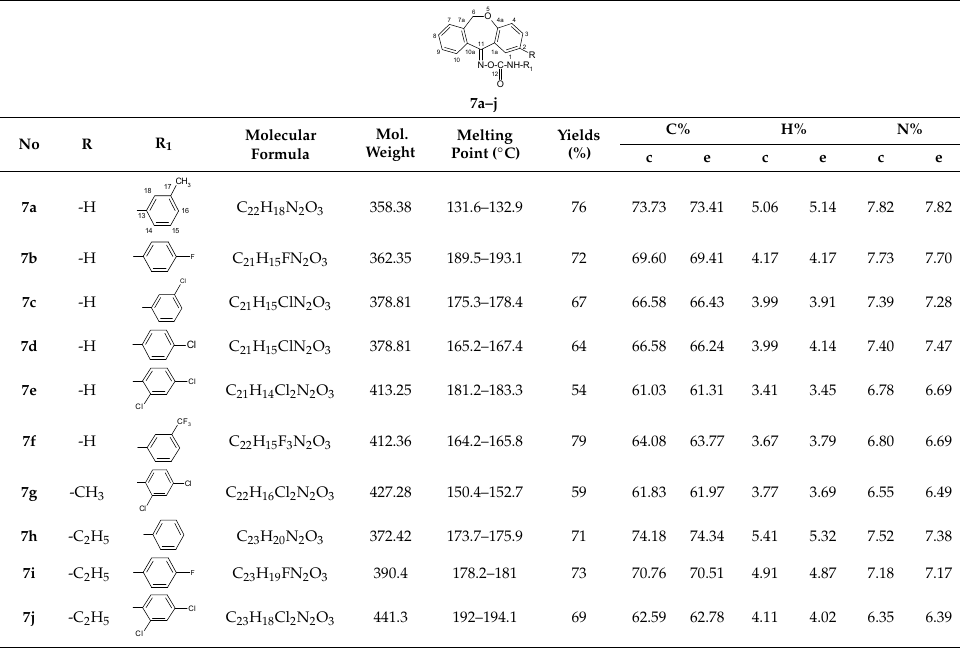
Molecules 2020 , 25 , x Table 7. Characterization data of the new compounds. Table 7. Characterization data of the new compounds. Table 7. Characterization data of the new compounds. Table 7. Characterization data of the new compounds. Table 7. Characterization data of the new compounds. Table 7. Characterization data of the new compounds. Table 7. Characterization data of the new compounds. Table 7. Characterization data of the new compounds. Table 7. Characterization data of the new compounds. Table 7. Characterization data of the new compounds. Table 7. Characterization data of the new compounds. Table 7. Characterization data of the new